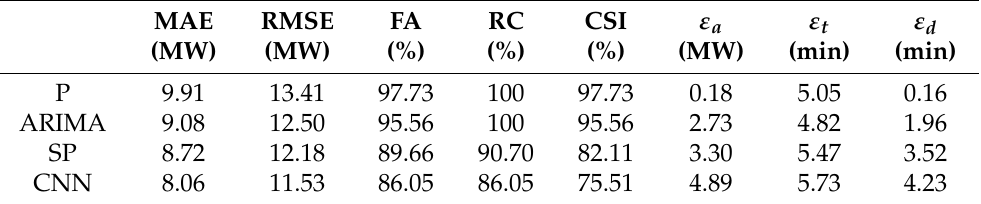
Figure 10. Ramp rise time ( ∆ T) versus ramp amplitude ( ∆ P ) for the 96 ramps identified throughout the assessment period. The ramp amplitude is expressed as a percentage of rated capacity (131.2 MW). The black circles and green crosses designate upward and downward ramps, respectively. Table 4. Ramp detection and forecasting statistics for the four methods, including the MAE, RMSE, forecast accuracy (FA), ramp capture (RC), critical success index (CSI), as well as average amplitude ( ε a ), timing ( ε t ) and duration error ( ε d